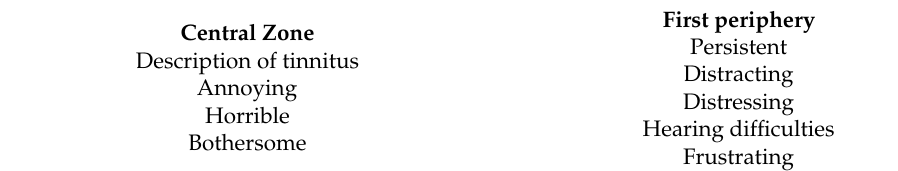
Table 4. Prototypical analysis of tinnitus responses.